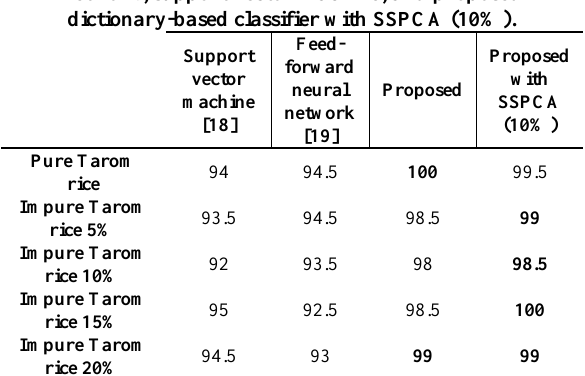
Table 9. Results of the accuracy rate for the Tarom rice classification and detection of its purity or impurity based on the combinational features for the neural network, support vector machine, and proposed dictionary-based classifier with SSPCA